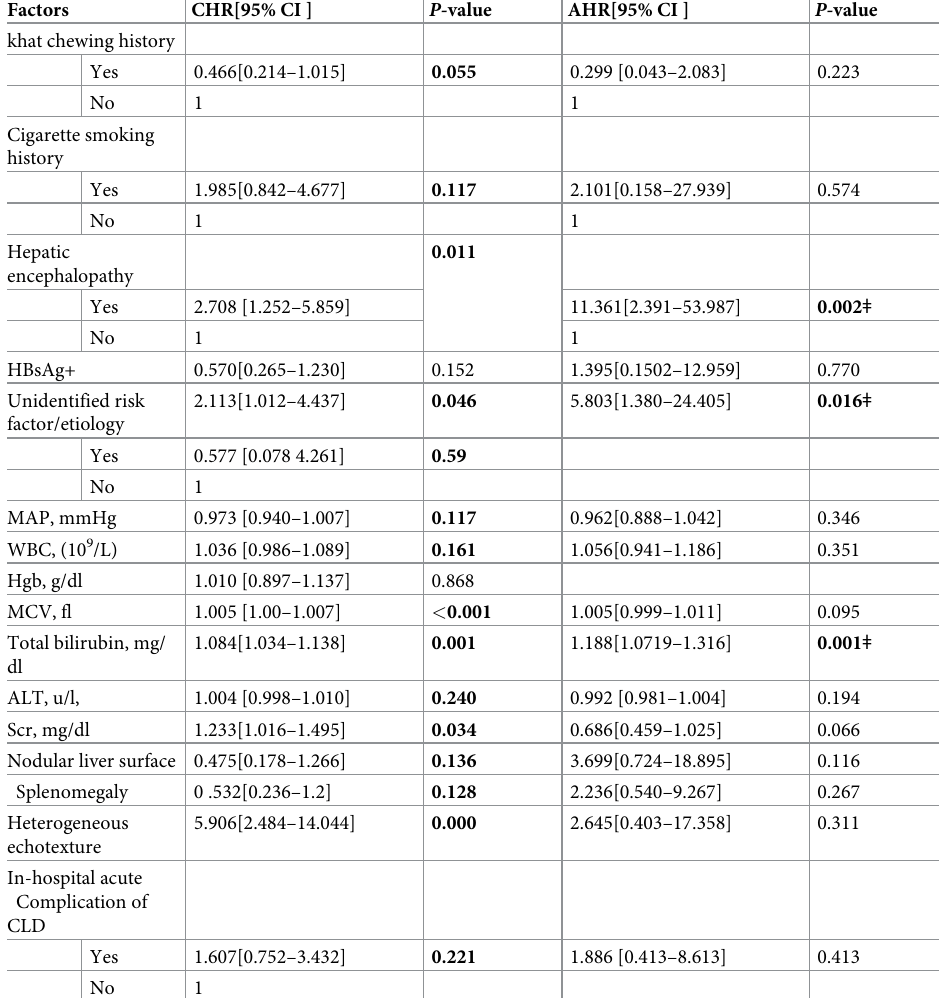
Table 4. Cox-regression survival analysis of patients hospitalized with Chronic liver disease (CLD) in relation to selected clinical findings as predictors.